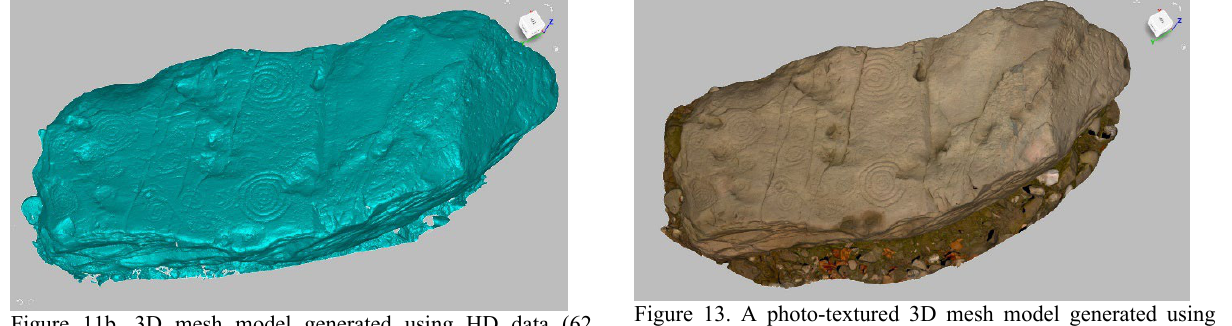
Figure 11b. 3D mesh model generated using HD data (62 million polygons).